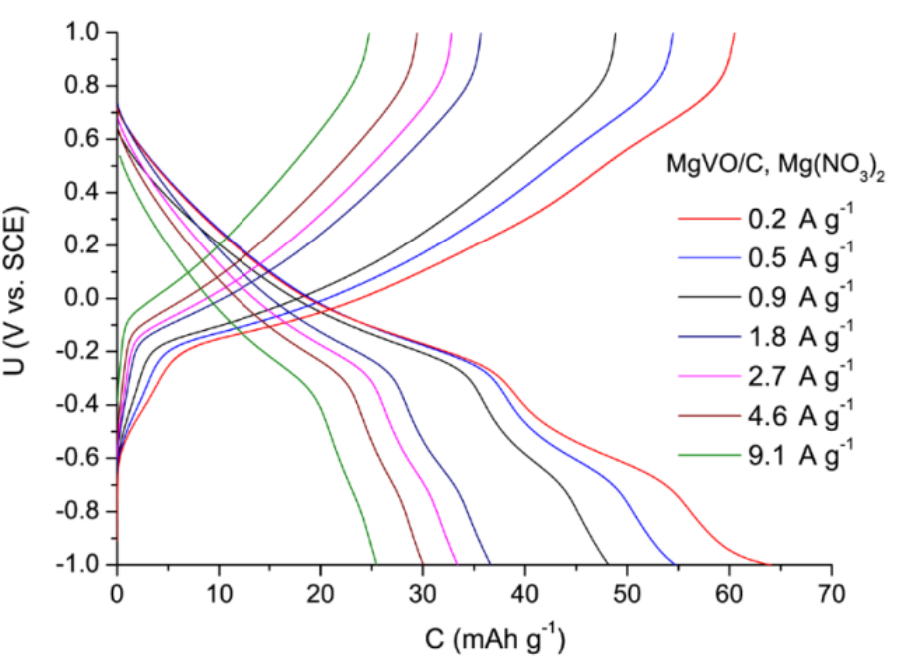
Figure 10. Chronopotentiometric curves of the MgVO/C in 3M Mg(NO 3 ) 2 , recorded at different current values.